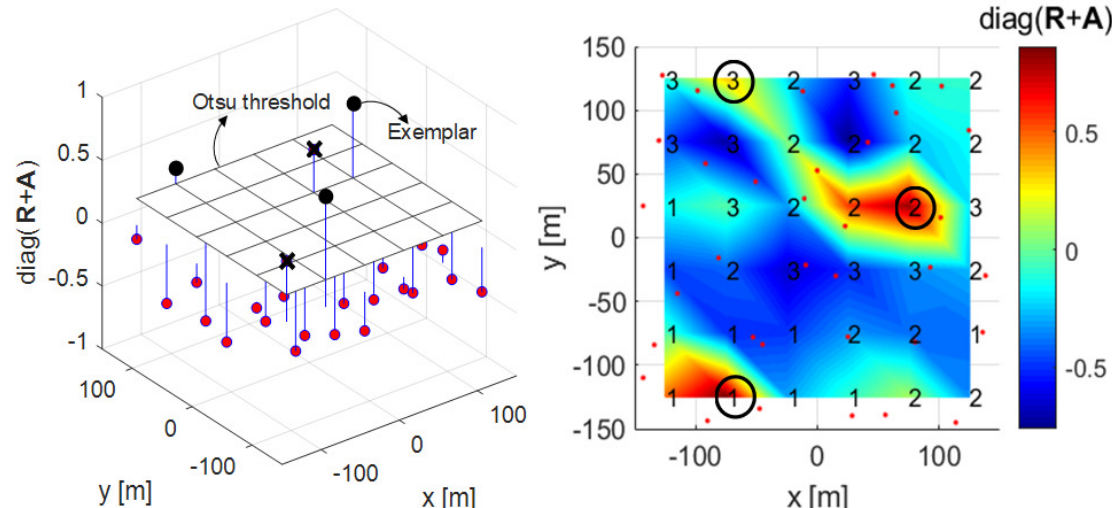
Figure 8. 3-D plot (left) and mesh plot (right) with Otsu threshold and greedy merging algorithm applied to the diagonal components of R + A in Algorithm